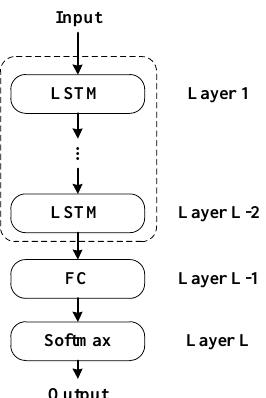
Figure 3. The architecture of the DNN model.